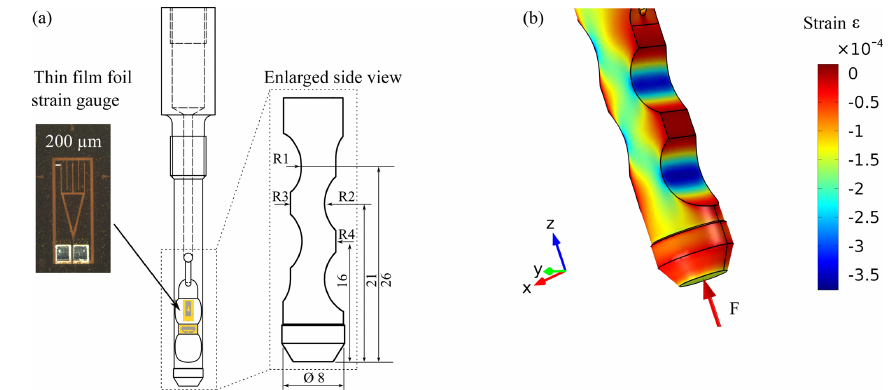
Figure 2. (a) Schematic drawing of the compression rod. The enlarged side view shows the resistances R1 to R4, which are connected to a Wheatstone bridge measuring the compression rod’s deformation. All dimensions in millimetres. (b) Structural FE analysis of the force compression rod. Table 2. Material properties of the membrane-type sensor elements. Material